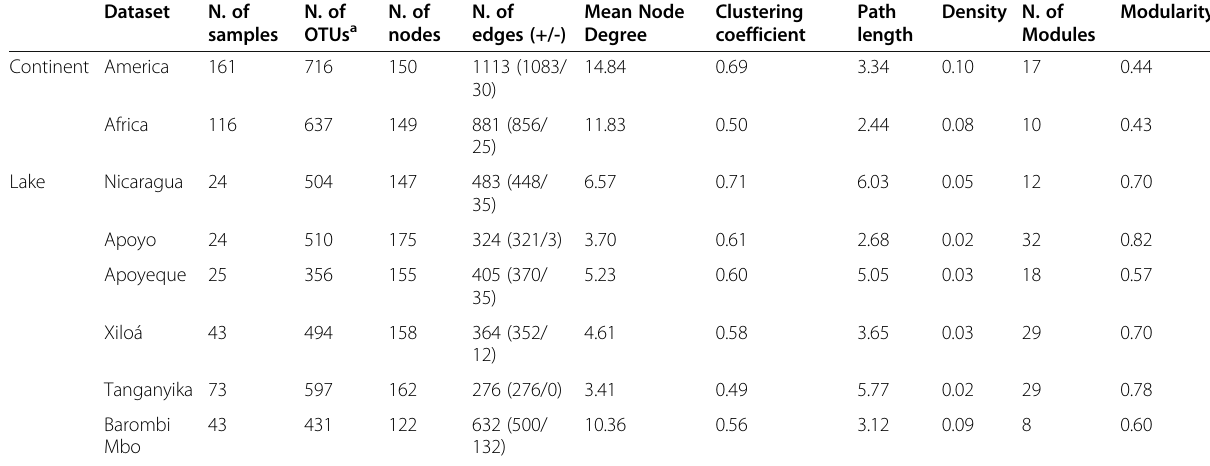
Table 1 Global network topologies